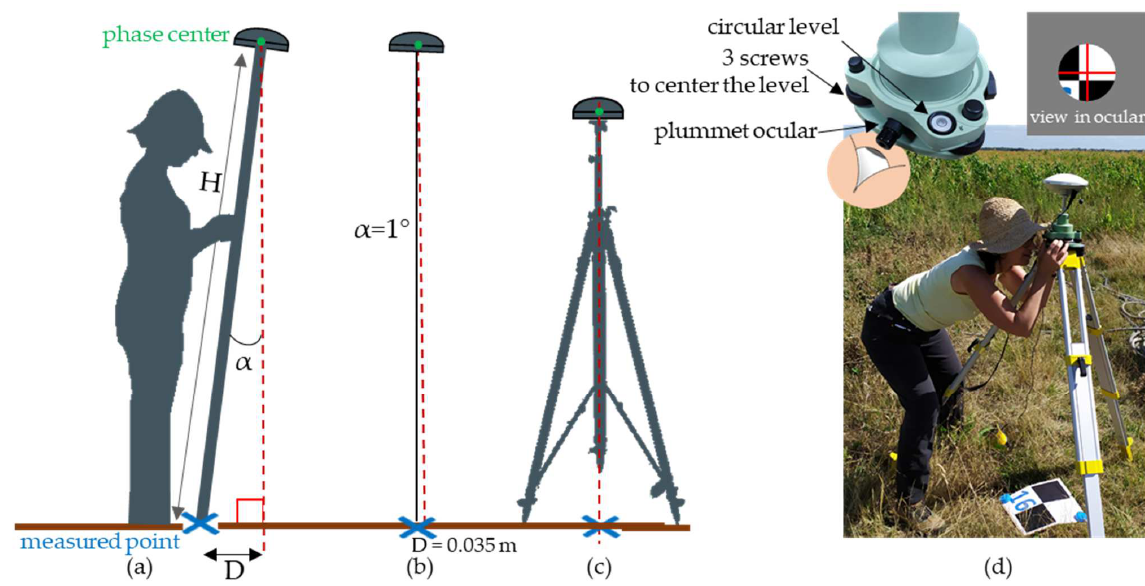
Figure 4. Geo7x GNSS measurement accuracy in pole and tripod mode. ( a ) Pole mode with H the height of the antenna on the pole, α the inclination of the rod with respect to the vertical and D the distance between the tip of the pole and the vertical projection on the ground of the phase center of the antenna; ( b ) inclination of the rod of one degree results in a ground error of 3.5 cm; ( c ) tripod mode; ( d ) Leica GDF322 professional tribrach with optical plummet was used with the tripod for greater accuracy.